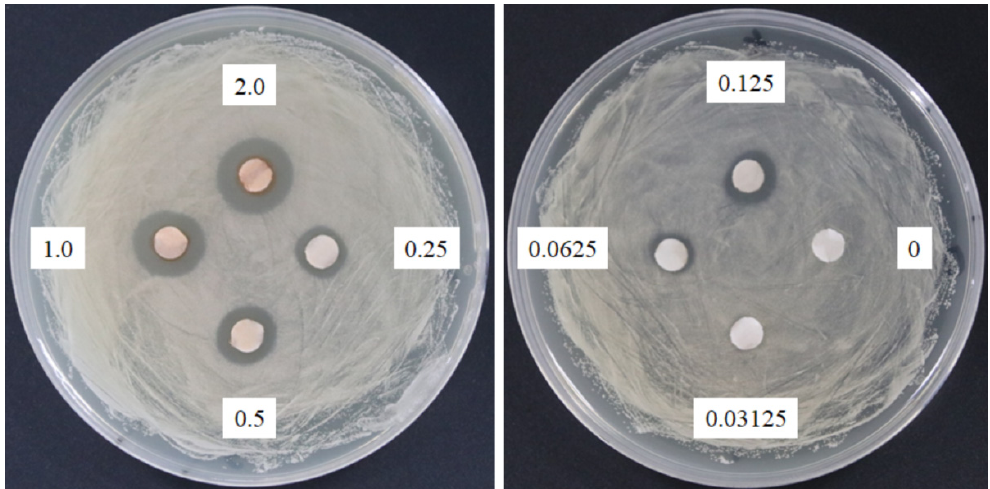
Figure 2. Anticandidal activity analysis of SSE. The 6 mm paper discs with different concentrations of SSE (0, 0.03125, 0.0625, 0.125, 0.25, 0.5, 1, and 2 mg) were placed on the plates with spread C. albicans . The plates were cultured at 37 °C for 24 h, and the growth inhibitions of C. albicans were observed.